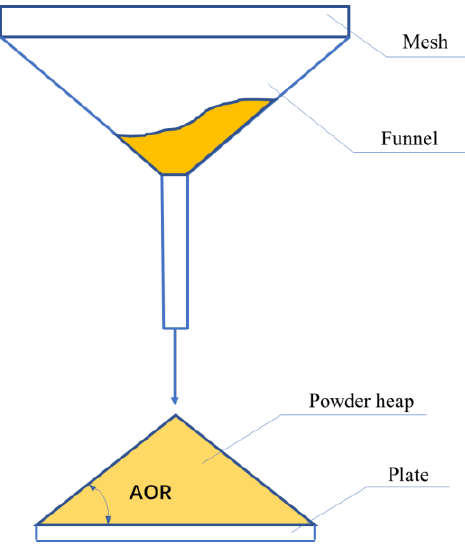
Figure 2. Schematic of AVA measurement.